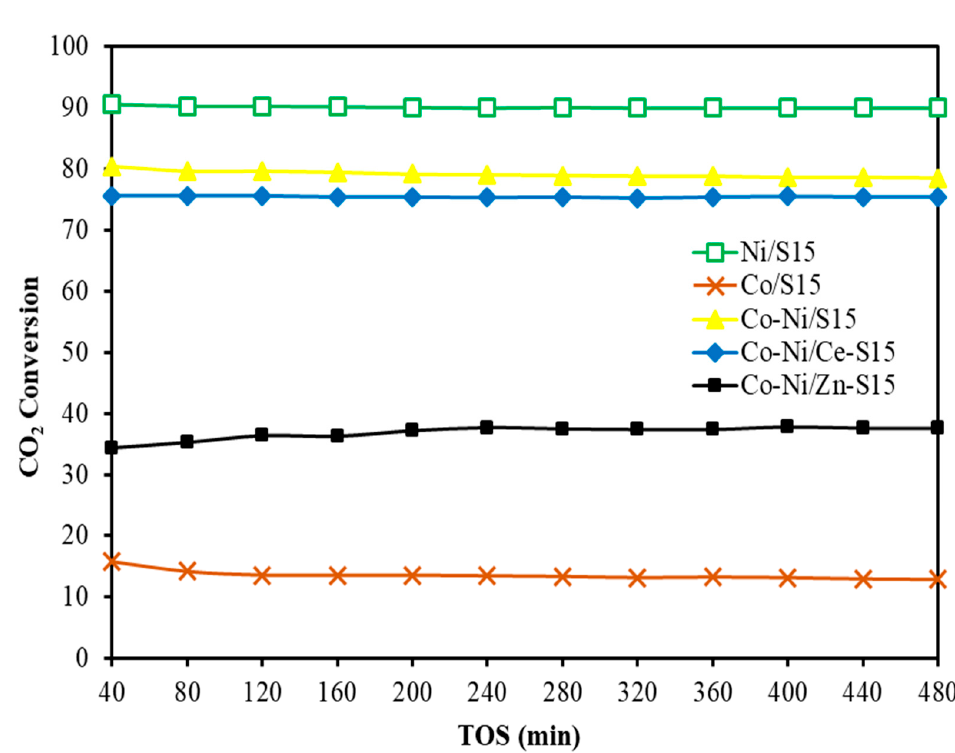
Figure 5. CO 2 conversion versus time-on-stream (min).